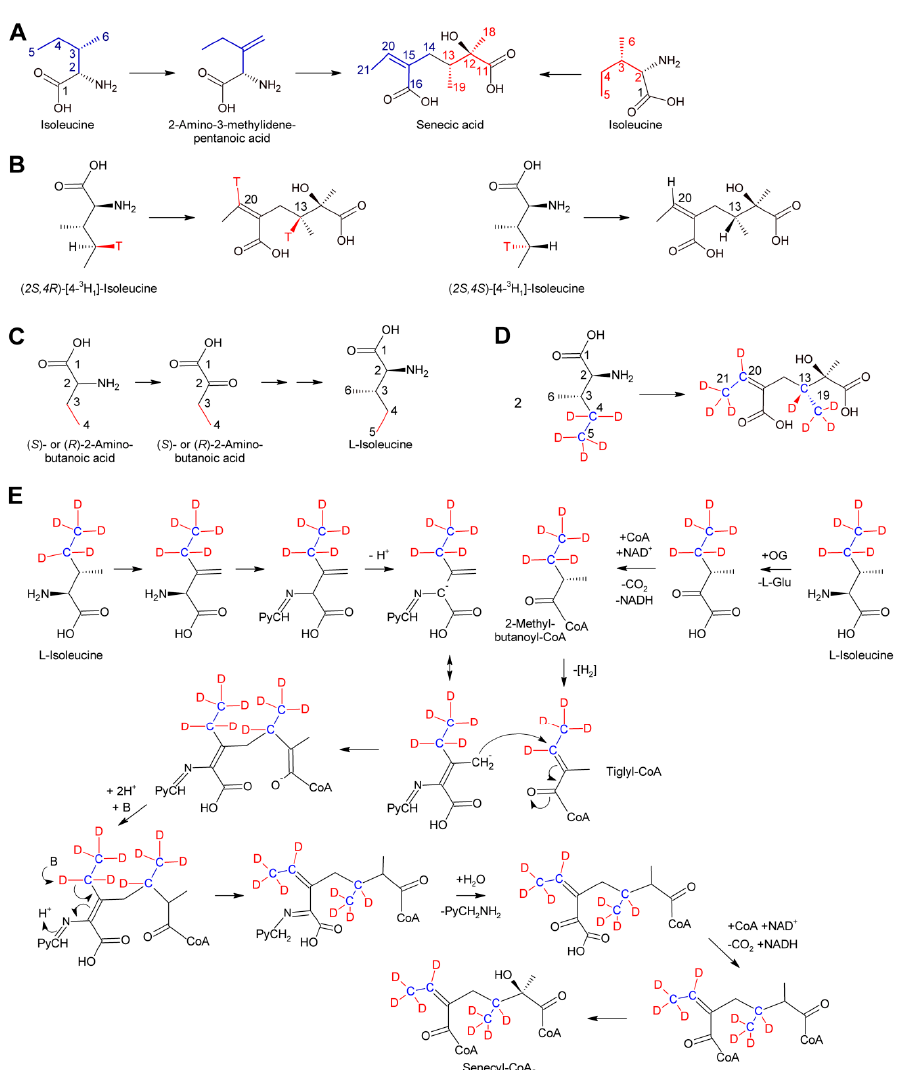
Figure 14. Biosynthesis of senecic acid. ( A ) Feeding experiments with 14 C-labeled compounds showed that senecic acid is formed from two L -isoleucine molecules accompanied by loss of both carboxy carbons. 2-Amino-3-methylenepentanoic acid might be an intermediate, although it is not clear whether for one or both halves of senecic acid. Carbons are numbered according to Reference [112]. ( B ) Feeding with L -isoleucine stereospecifically labeled with 3 H (tritium, T) at C-4 showed that only the 4R label was retained upon incorporation. ( C ) 2-Aminobutanoic acid is converted in planta to L -isoleucine. Due to 2-ketobutanoic acid as intermediate the initial stereochemistry of 2-aminobutyric acid is irrelevant. A label ( 13 C or 3 H; red) at C-3 and C-4 is retained and found on position C-5 and C-6 in L -isoleucine. ( D ) The 13 C-labeled C-4 and C-5 (blue) of L -leucine (obtained in planta from labeled 2-aminobutanoic acid) and most of the 2 H (deuterium, D; red) is retained upon incorporation into senecic acid. ( E ) Possible mechanism for formation of senecic acid. CoA, coenzyme A; L -Glu, L -glutamic acid; NAD + /NAHD, oxidized/reduced nicotinamide adenine dinucleotide; OG, 2-oxoglutaric acid; and Py,